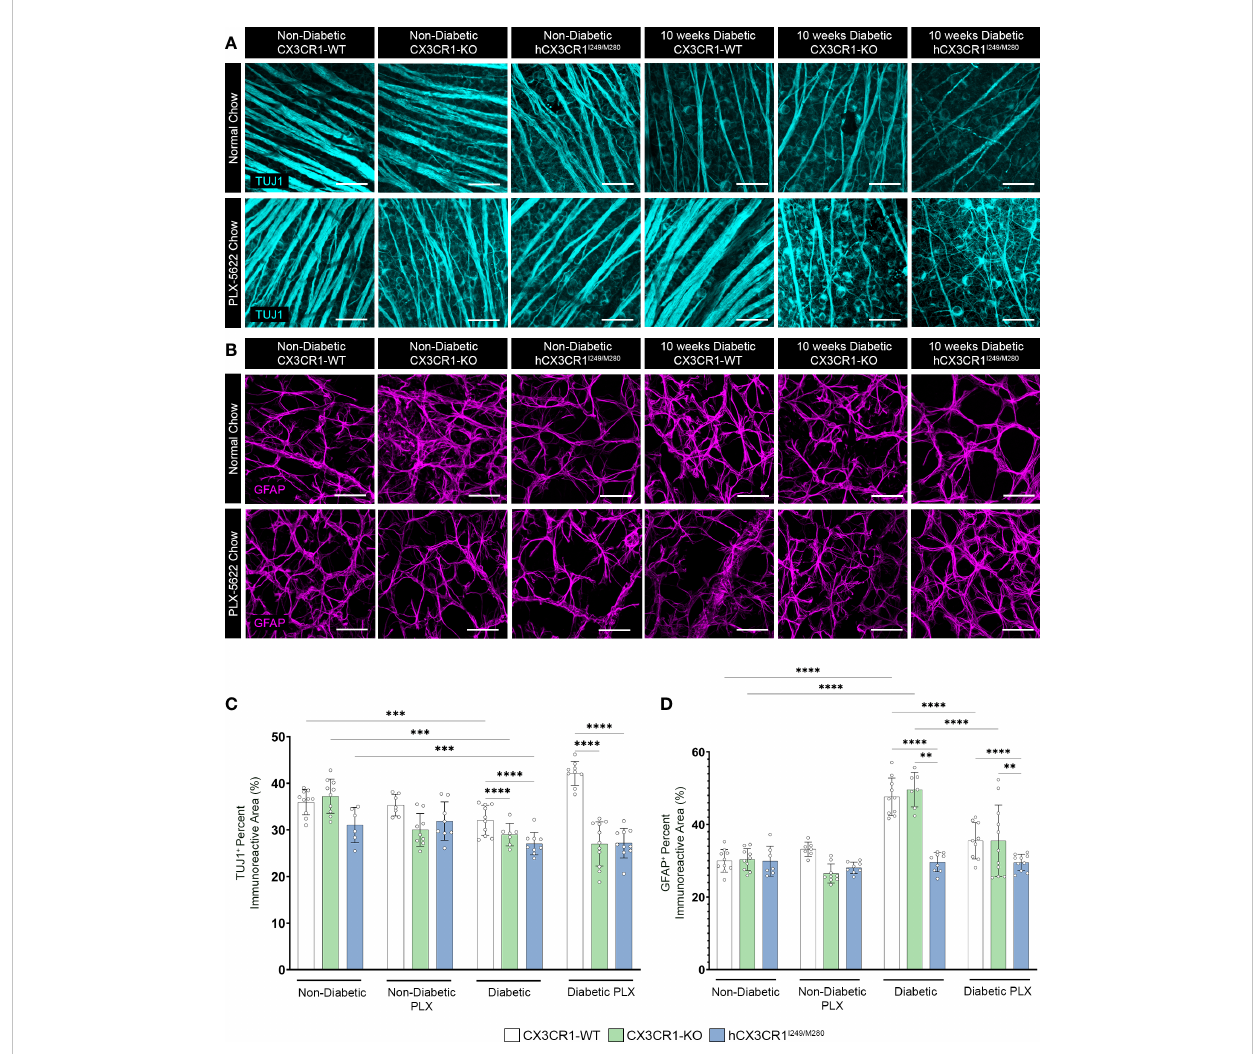
FIGURE 4 PLX-5622 treatment does not prevent TUJ1 + axonal loss in the diabetic CX3CR1 -KO and hCX3CR1 I249/M280 retinas. Microglia were pharmacologically depleted using PLX-5622 in non-diabetic and 8-wks diabetic CX3CR1 -WT, CX3CR1 -KO, and hCX3CR1 I249/M280 mice for two weeks. Non-diabetic control mice received citrate buffer. Non-depleted, non-diabetic and diabetic controls remained on normal chow. Confocal images of retinal tissues stained for TUJ1 (turquoise) (A) and GFAP (magenta) (B) in CX3CR1 -WT, CX3CR1 -KO and hCX3CR1 I249/M280 mice. Confocal images represent the retinal ganglion cell layer in the peripheral retina. (C, D) , Quanti fi cation of retinal IHC analysis for TUJ1 + percent immunoreactive area (C) and GFAP + percent immunoreactive area (D) . Data show the average of the 2 central, 2 medial and 2 peripheral images taken per mouse. Data show mean ± SD, n = 6 to 10 mice per group where each dot represents an individual mouse. ** P <0.01, *** P <0.001, **** P <0.0001 using 2-way ANOVA. Scale bars measure